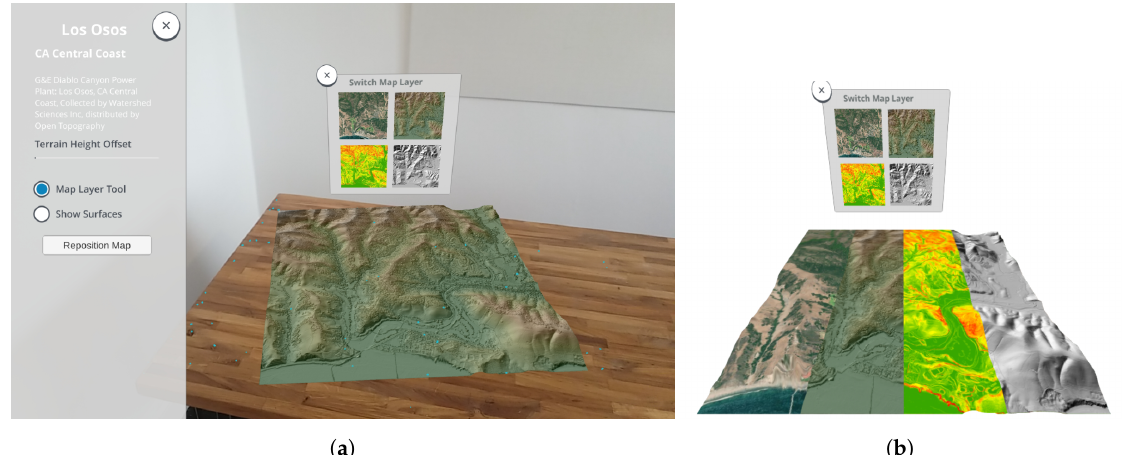
Figure 4. Augmented reality cartographic visualisations. ( a ) 3D Terrain draped with a coloured relief map anchored to a table using environmental tracking. ( b ) A close up of the Map Layer Tool, showing the ability to instantly visualise and select from a range of base map styles. Underlying DEM data from the Los Osos, CA Central Coast [21].